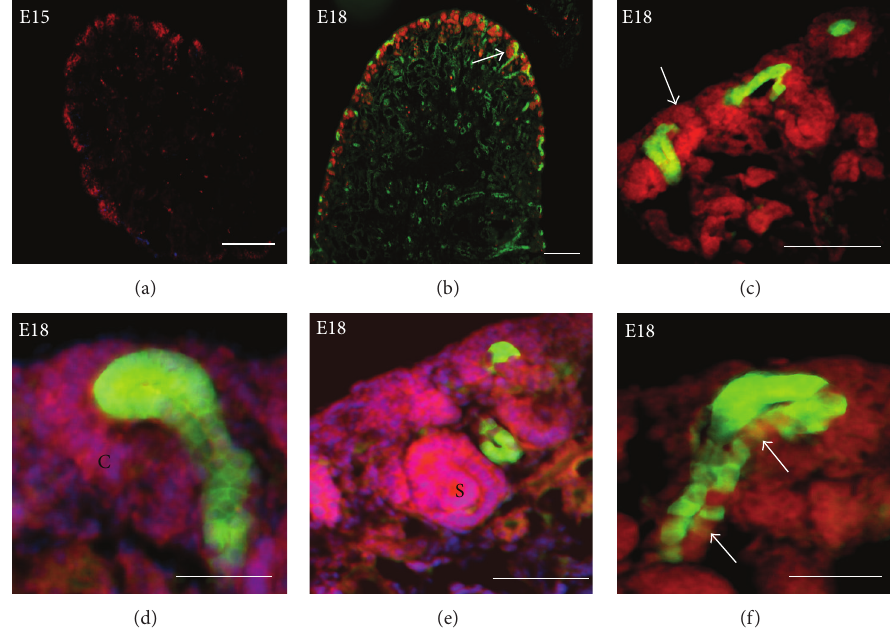
Figure 3: CD24 expression in embryonic mouse kidney. (a) PE-red-tagged CD 24+ cells are seen predominantly in the nephrogenic zone of E15 mouse kidney. (b-c) In E18 kidney from Hoxb7 -GFP transgenic mice, CD 24+ cells (red) are seen in the cap mesenchyme associated with ureteric bud branch tips (green). (d-e) At high power, CD 24+ cells (red) are seen within comma-shaped (C) and S-shaped (S) bodies of emerging nephrons. (f) Occasional CD 24+ cells (red) are seen within the ureteric bud trunk (green) of E18 Hoxb7 -GFP mice. Scale bar: 50 𝜇